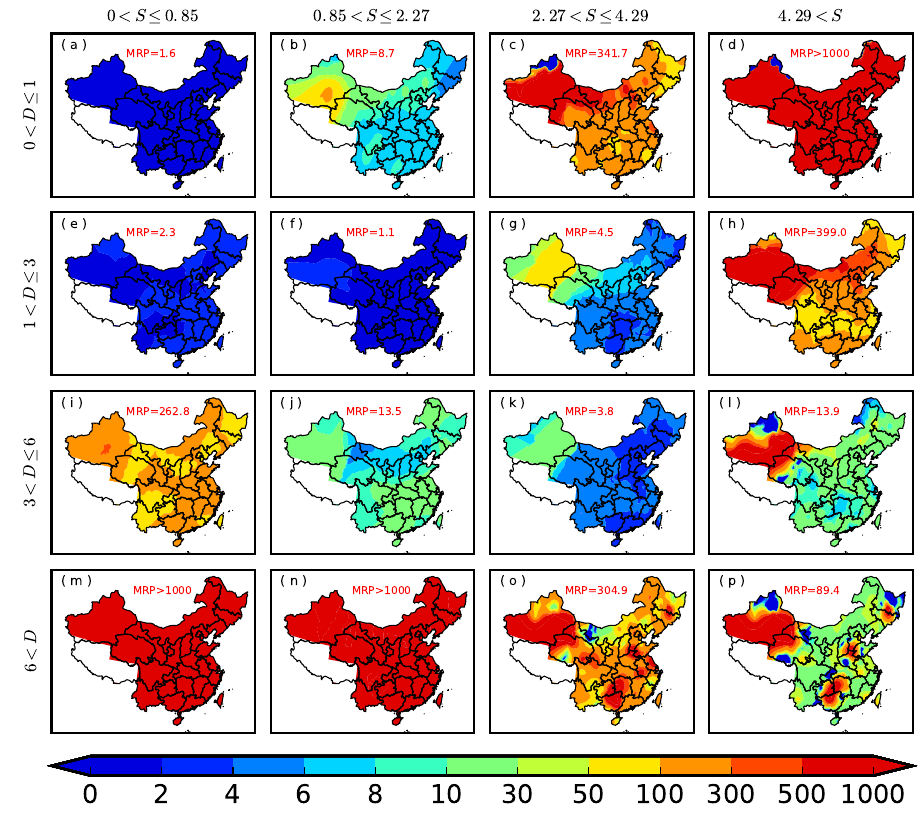
Figure 12. Return period based on semiempirical method (the unit of the colored bar is years). ( a – p ) represent the different drought